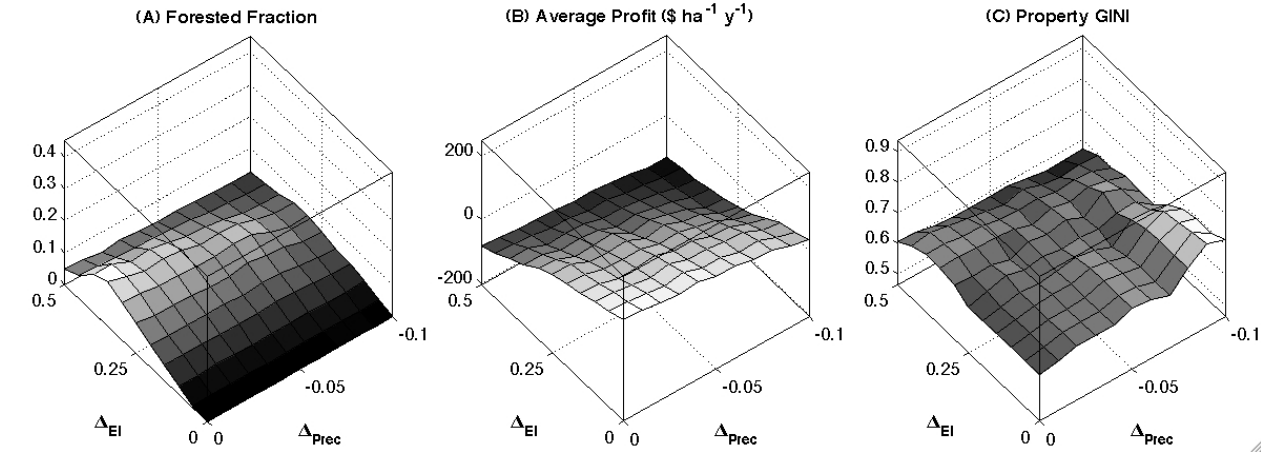
Fig. 3. Response surfaces for Policy Scenario 1 (nontiered environmental licensing), Rancher Scenario 1 (low networking, low size effect) showing sensitivity to change in expected income D EI and in precipitation D Prec. (A) Average forested fraction across the landscape; (B) Average profit per hectare of property per year; (C) Level of land aggregation measured by the property GINI coefficient. Response surfaces for Rancher Scenarios 1-4 are shown in Appendix 5, as are surfaces for the standard deviations across